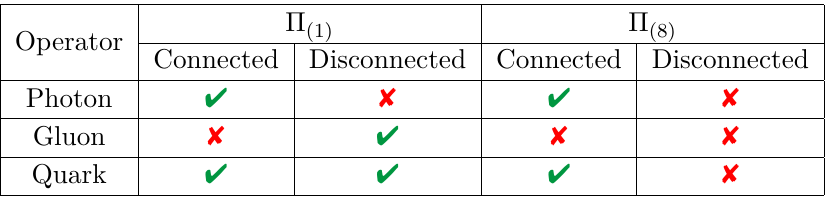
Table 1 . Summary of studied contributions entering at dimension D = 4